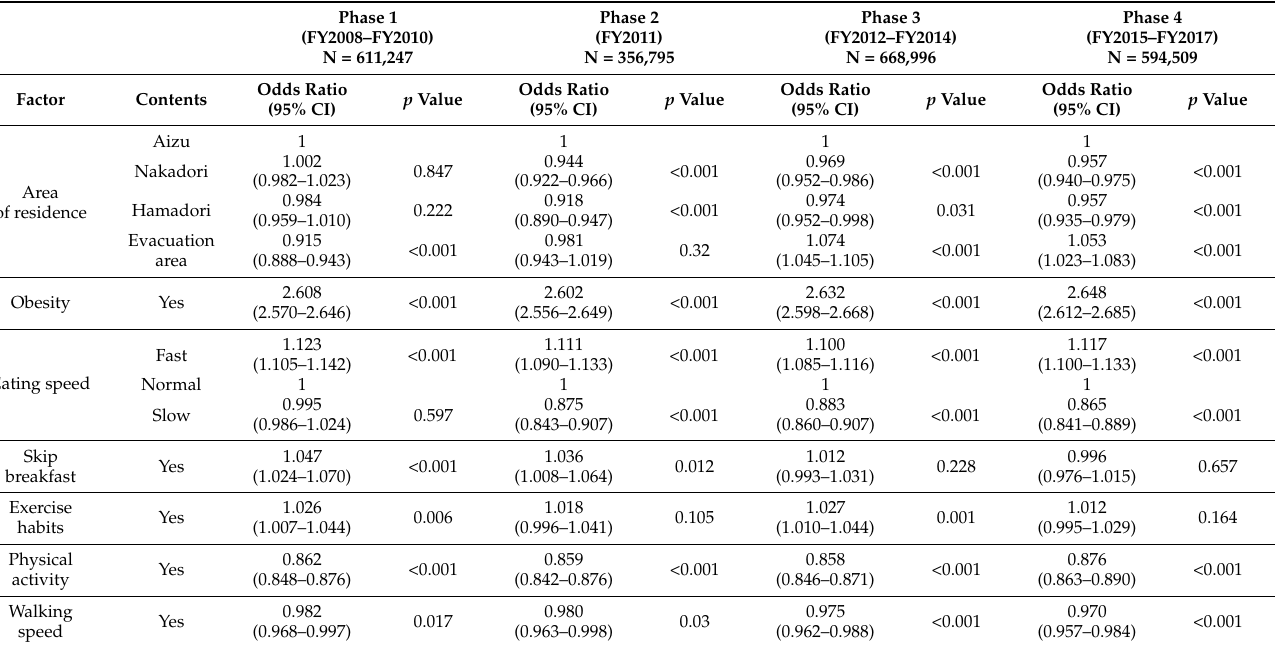
Table 5. Multivariable logistic regression analysis to determine the effect of region of residence on dyslipidemia prevalence in each phase after adjusting for specific